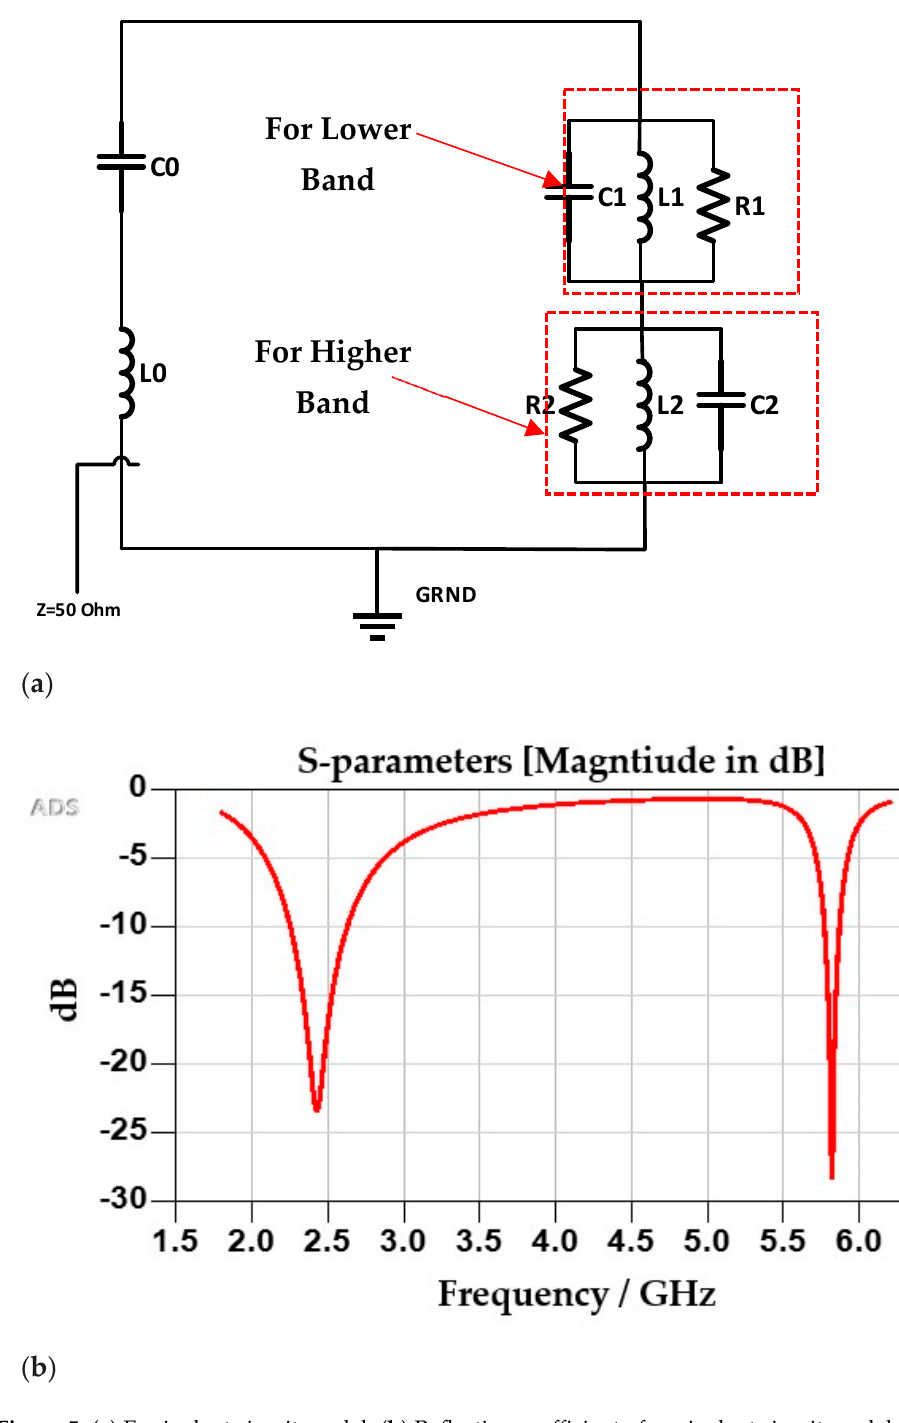
Figure 5. ( a ) Equivalent circuit model. ( b ) Reflection coefficient of equivalent circuit model.